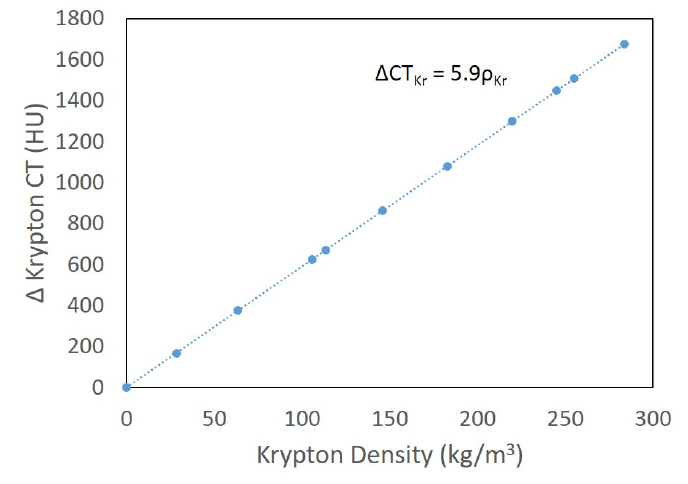
Figure 2. Pure Kr density versus ∆ CT at 20 ◦ C scanned at 140 kV and 120